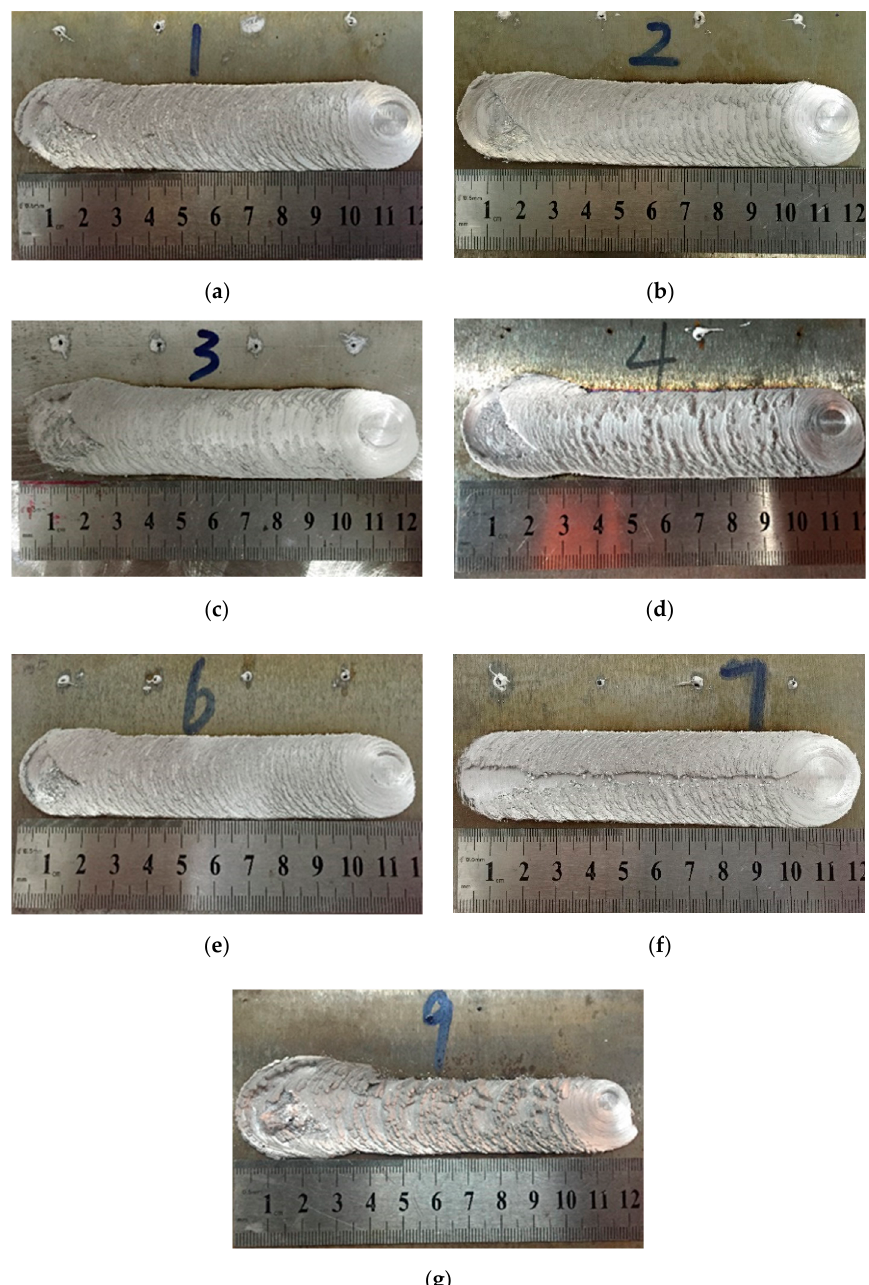
Figure 6. Deposition morphology at different process parameters, i.e., rotation speed (rpm), travel speed (mm/min), feed rate (mm/min): ( a ) 900, 80, 15; ( b ) 900, 80, 20; ( c ) 900, 80, 25; ( d ) 900, 60, 20; ( e ) 900, 100, 20; ( f ) 600, 80, 20; ( g ) 1200, 80, 20. Table 4. Deposition width and thickness.